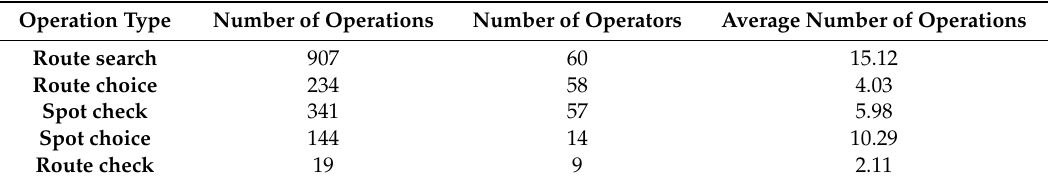
Table 2. Summary of application operation